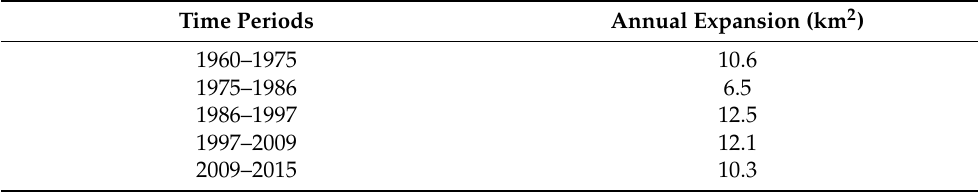
Table 3. Annual expansion in the FDB during